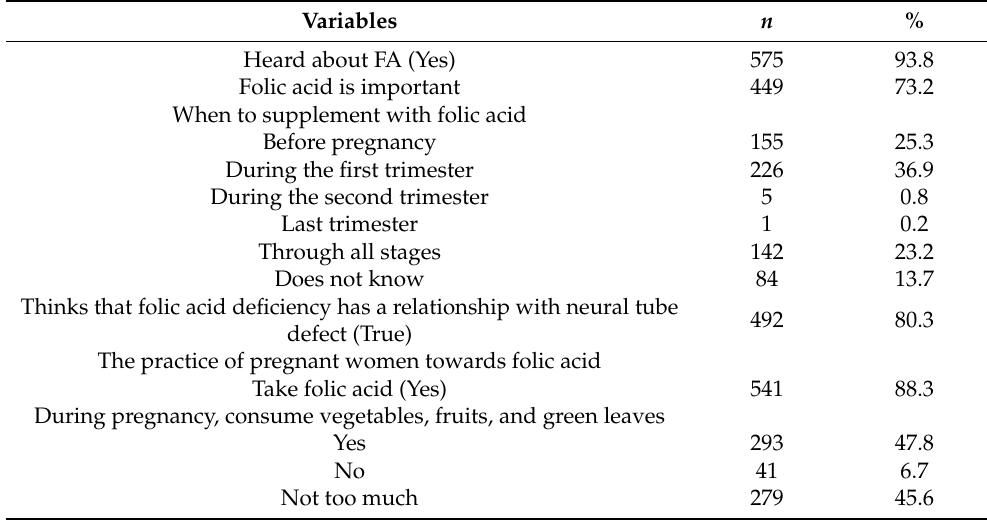
Table 2. Knowledge and practice of pregnant women about FA ( n =